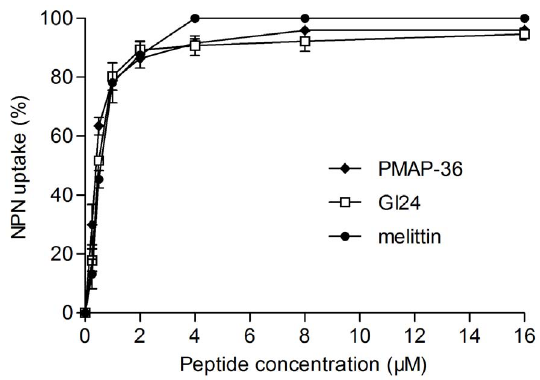
Figure 3. The uptake of NPN by E.coli UB1005 in the presence of different concentrations peptides. The ability of peptides to disrupt the outer membrane integrity of bacteria was evaluated with the fluorescent dye N-phenyl-1-naphthylamine (NPN). Changes in fluorescence were measured using an F-4500 fluorescence spectropho- tometer at an excitation wavelength of 350 nm and an emission wavelength of 420 nm.